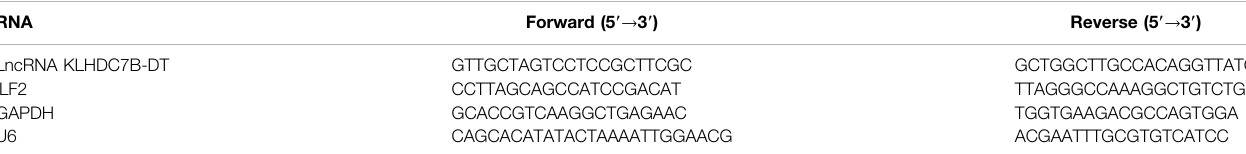
TABLE 2 | Sequences of primers for qRT – PCR.